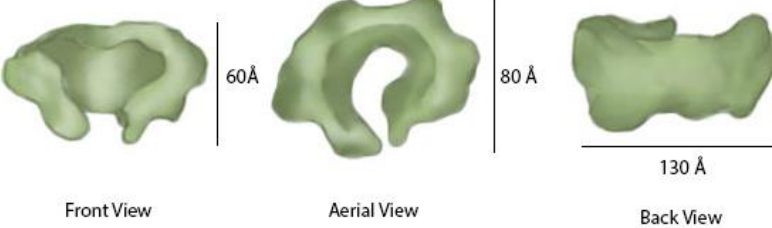
Figure 6. Architecture of the GINS complex. The architecture of the GINS structure, determined in isolation, is shown.